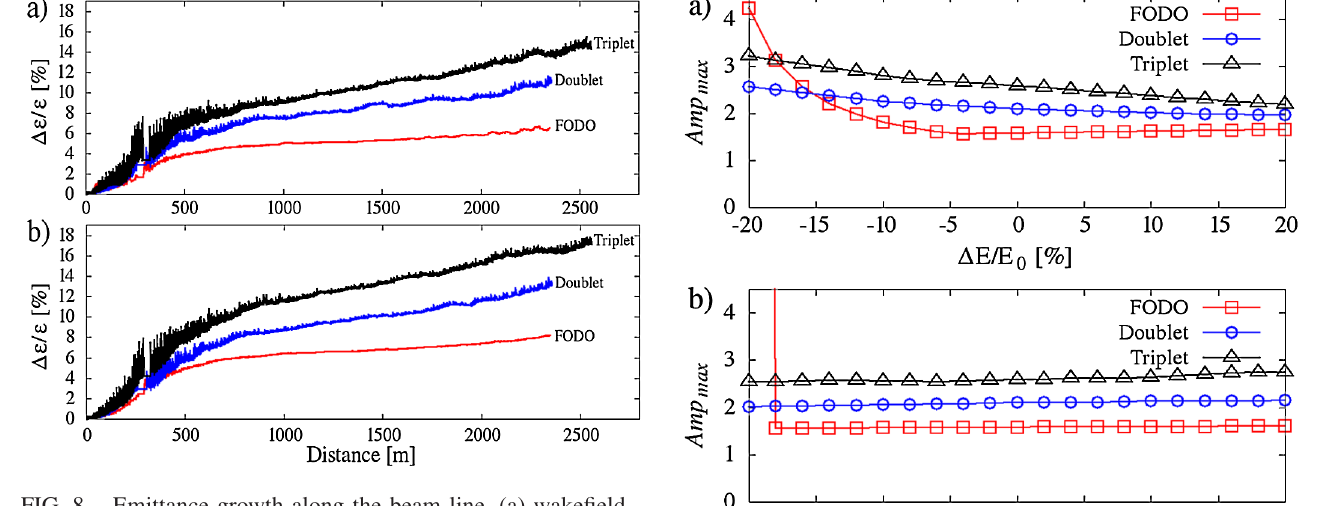
FIG. 8. Emittance growth along the beam line, (a) wakefield- free steering and (b) one-to-one correction.